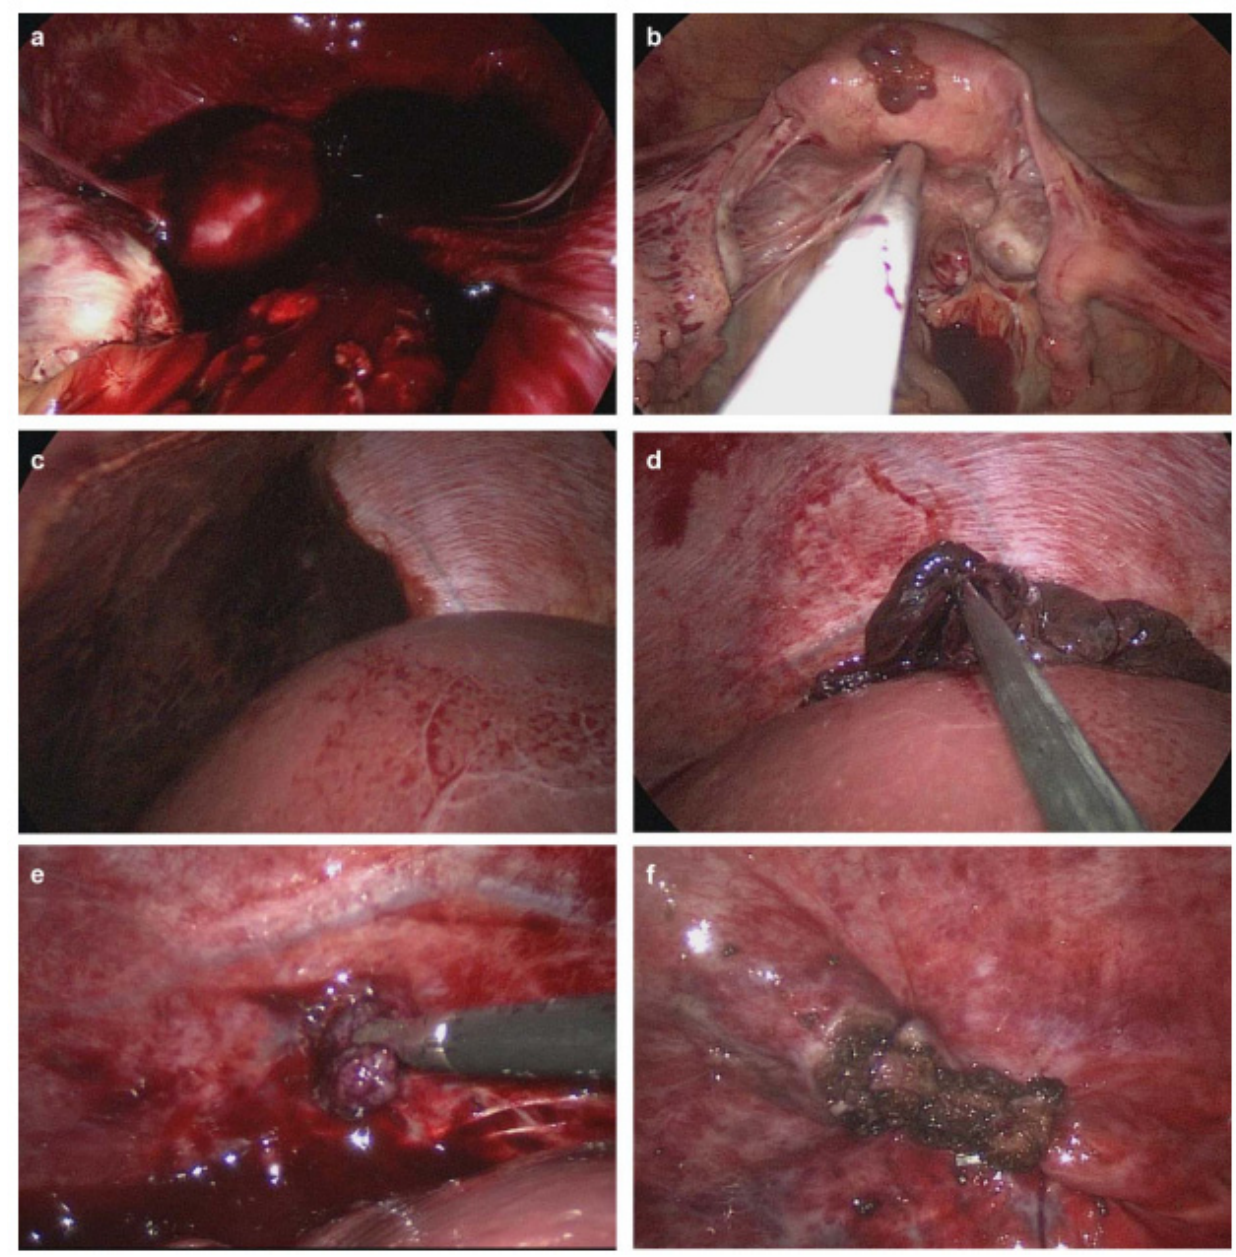
Figure 2. Images of laparoscopic surgery. ( a ) Blood clots in the pelvic cavity. ( b ) Normal uterus and bilateral tubes and ovaries. ( c ) Placental tissues with hematoma covering the diaphragm. ( d ) Removal of the placental tissues and hematoma. ( e ) Ectopic mass attached to, and invading, the diaphragm. ( f ) Complete removal of the ectopic mass from the diaphragm and suturing around the removal site.